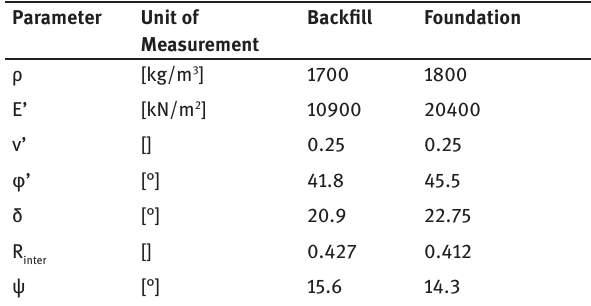
Table 2: Mohr-Coulomb Model Parameters.